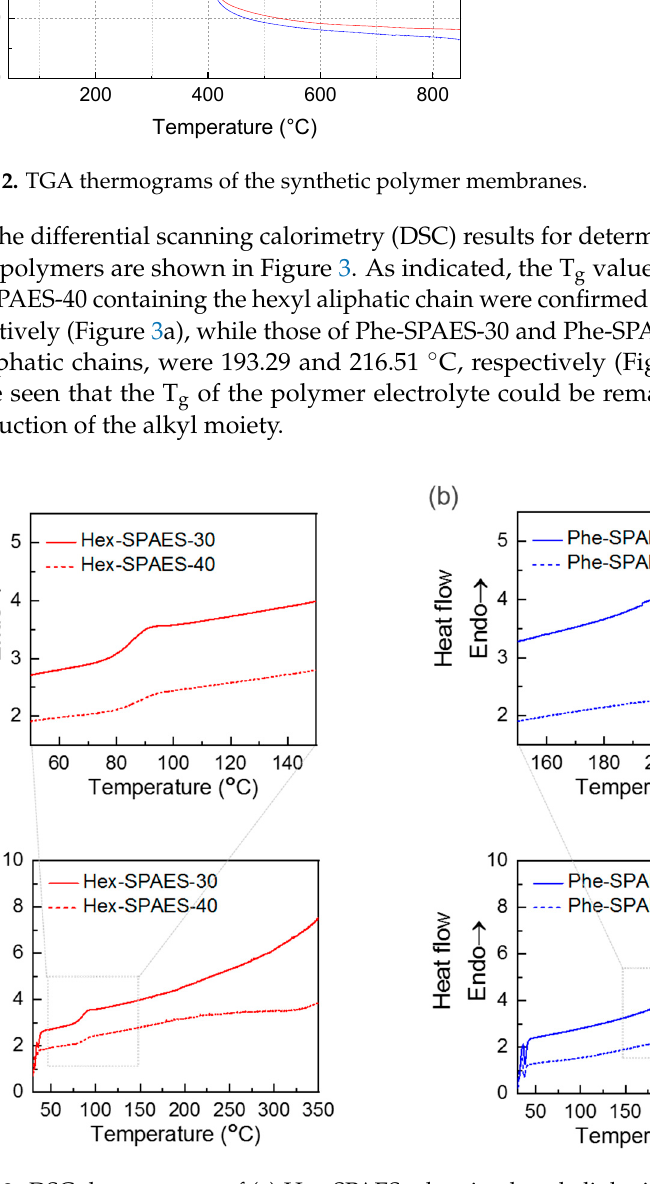
Figure 3. DSC thermograms of ( a ) Hex-SPAES-x bearing hexyl aliphatic chains; ( b ) Phe-SPAES-x containing no aliphatic chains, as recorded during the second scan.